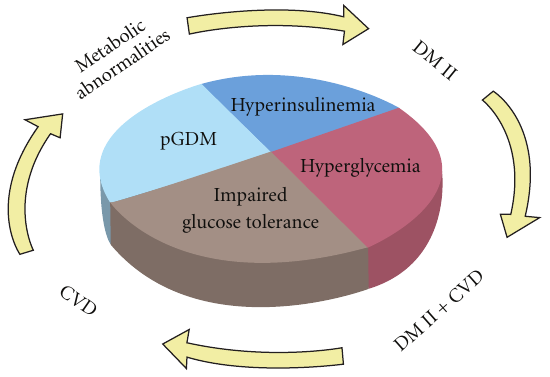
Figure 1: Metabolic status during pregnancy and pGDM may result in outcomes later in life like metabolic abnormalities, DMII, CVD, and DMII + CVD as it is shown following the